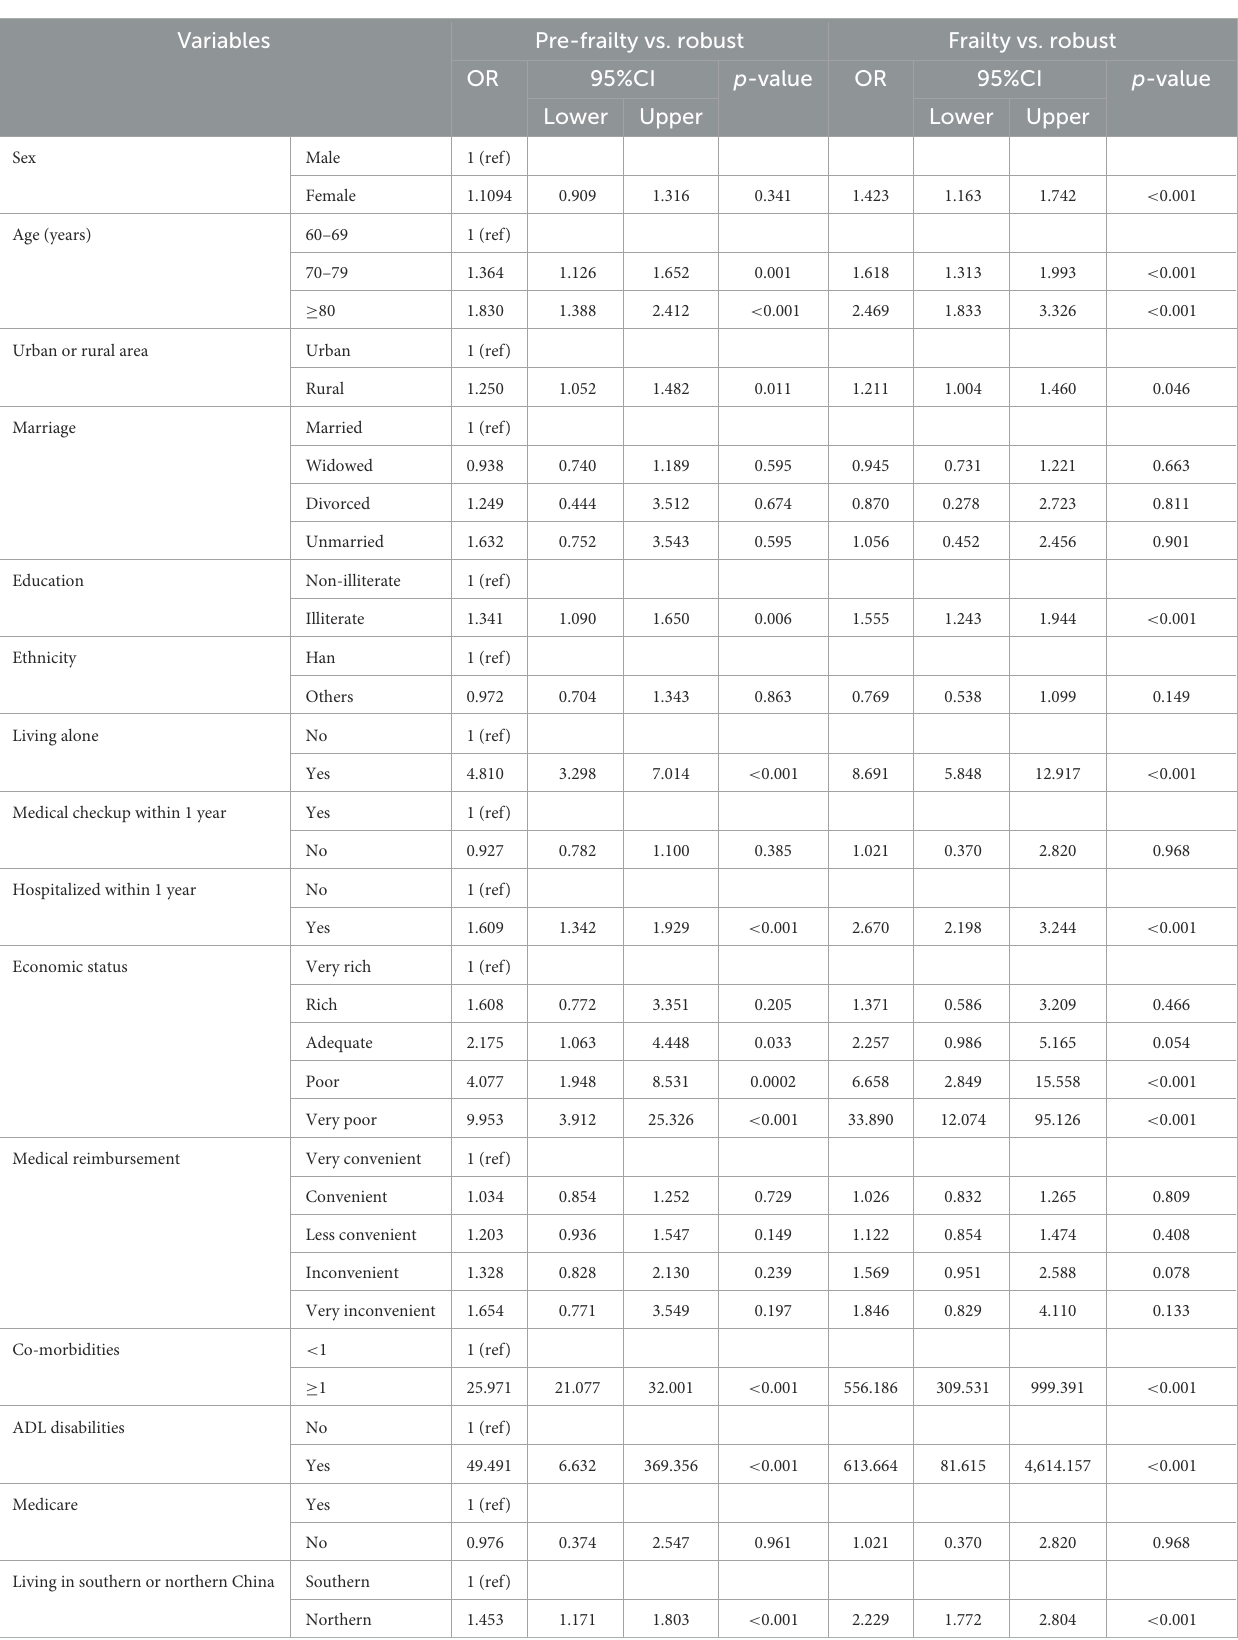
TABLE 3 Factors associated with frailty and pre-frailty of older adults with asthma by multinomial logistic regression. Variables Pre-frailty vs. robust Frailty vs. robust OR 95%CI OR 95%CI p -value Lower Upper Lower